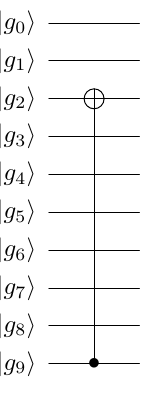
Circuit 4: Binary shift circuit for F g 9 + g 0 z + g 1 z 2 + ( g 2 + g 9 ) z 3 + g 3 z 4 + · · · + g 9 z 9 as the